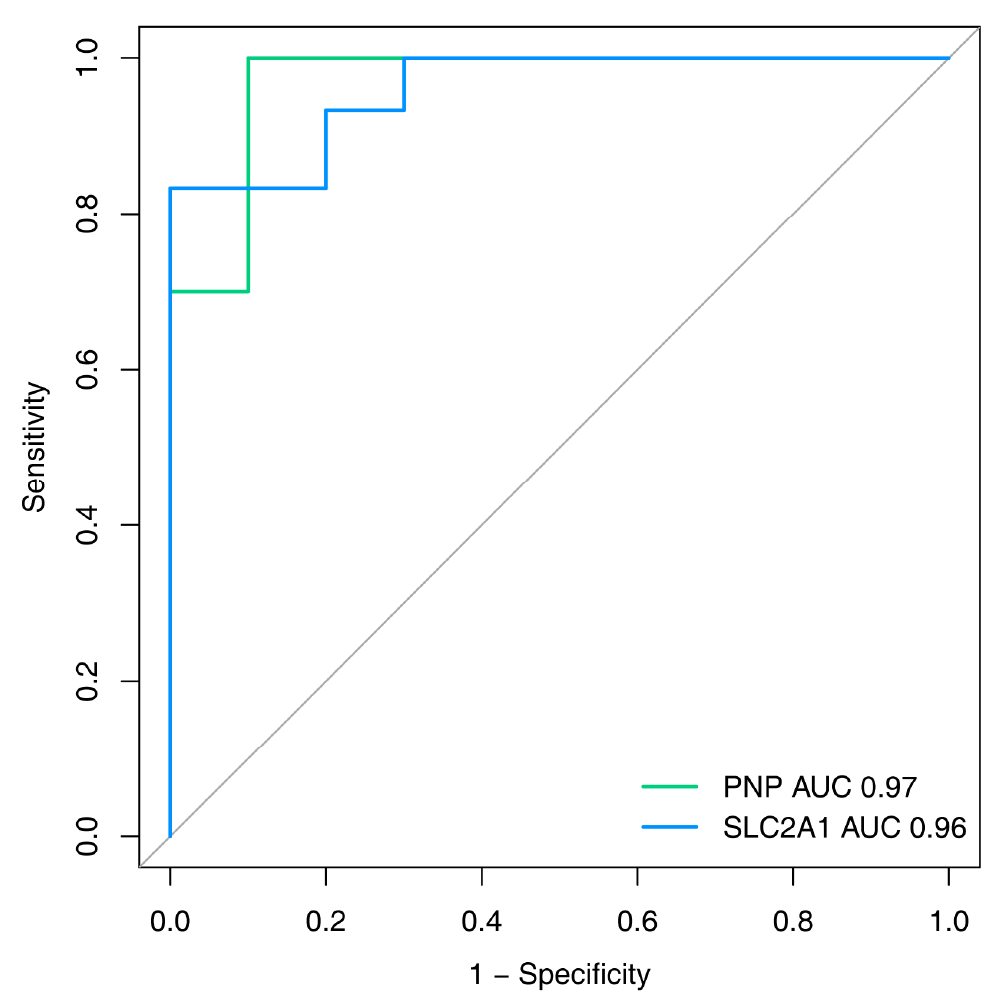
Figure 7. Receiver operating characteristic (ROC) curves of PNP and SLC2A1 in the GSE123568 dataset. The area under the curve (AUC) value of PNP was 0.97, and the AUC value of SLC2A1 was